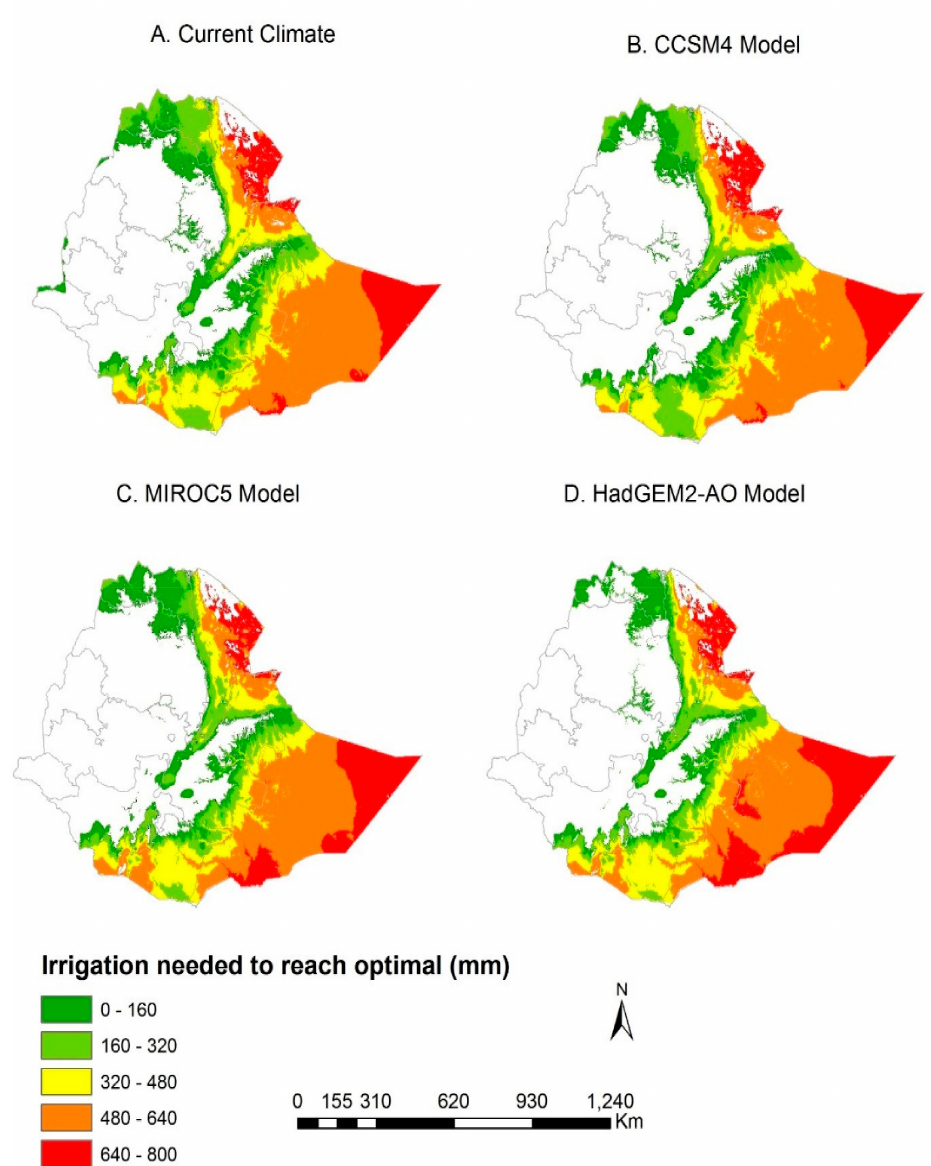
Figure 10. The spatial distribution of the rainfall deficit arears (mm) for alfalfa under current climate (1970–2000) and three global circulation models / scenarios (CCSM4, HadGEM2-AO and MIROC5) representing 4.5 representative concentration pathway (RCP) for the period of 2041–2060 in Ethiopia. The water deficit indicates the amount of irrigation needed to reach optimal crop water